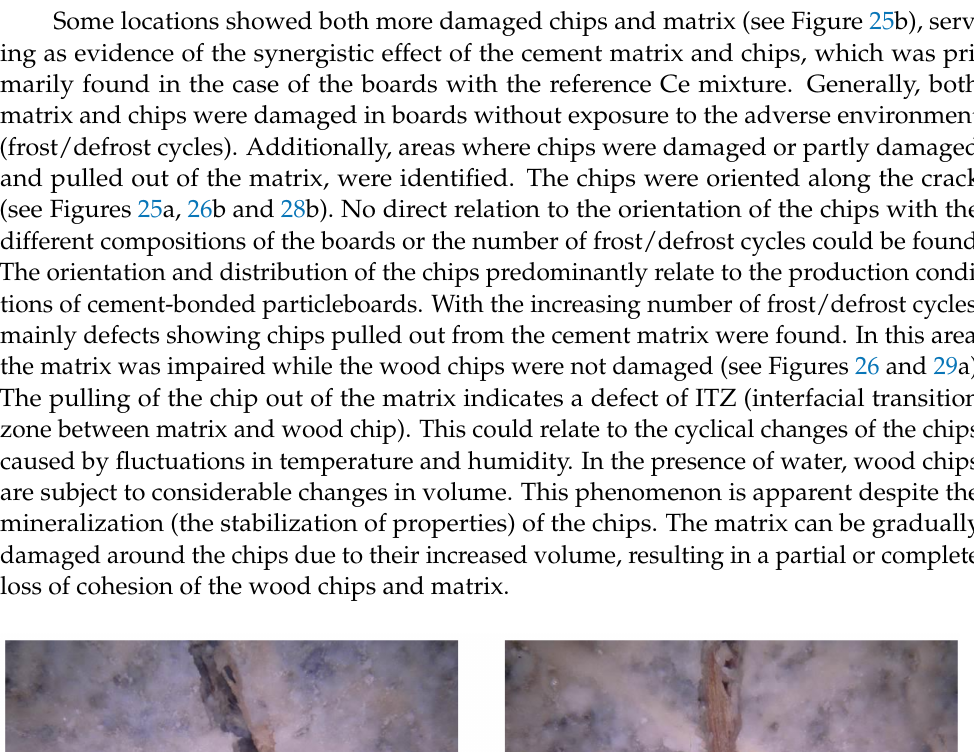
Figure 25. Detailed structure of crack in Ce-Ref—pictures from optical microscope: ( a ) chip oriented along with the crack; ( b ) defects both in matrix and chips.